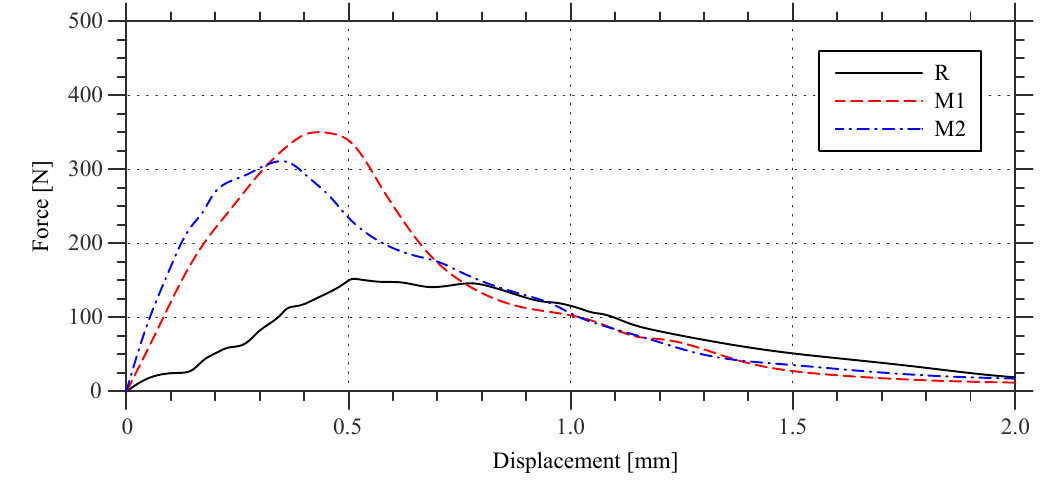
Figure 3. Force as a function of displacement revealed during pull-off experiment.